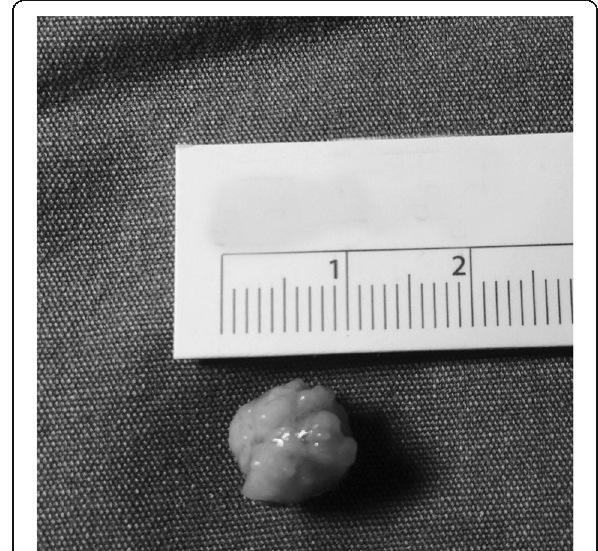
Fig. 3 Photo of tumor after